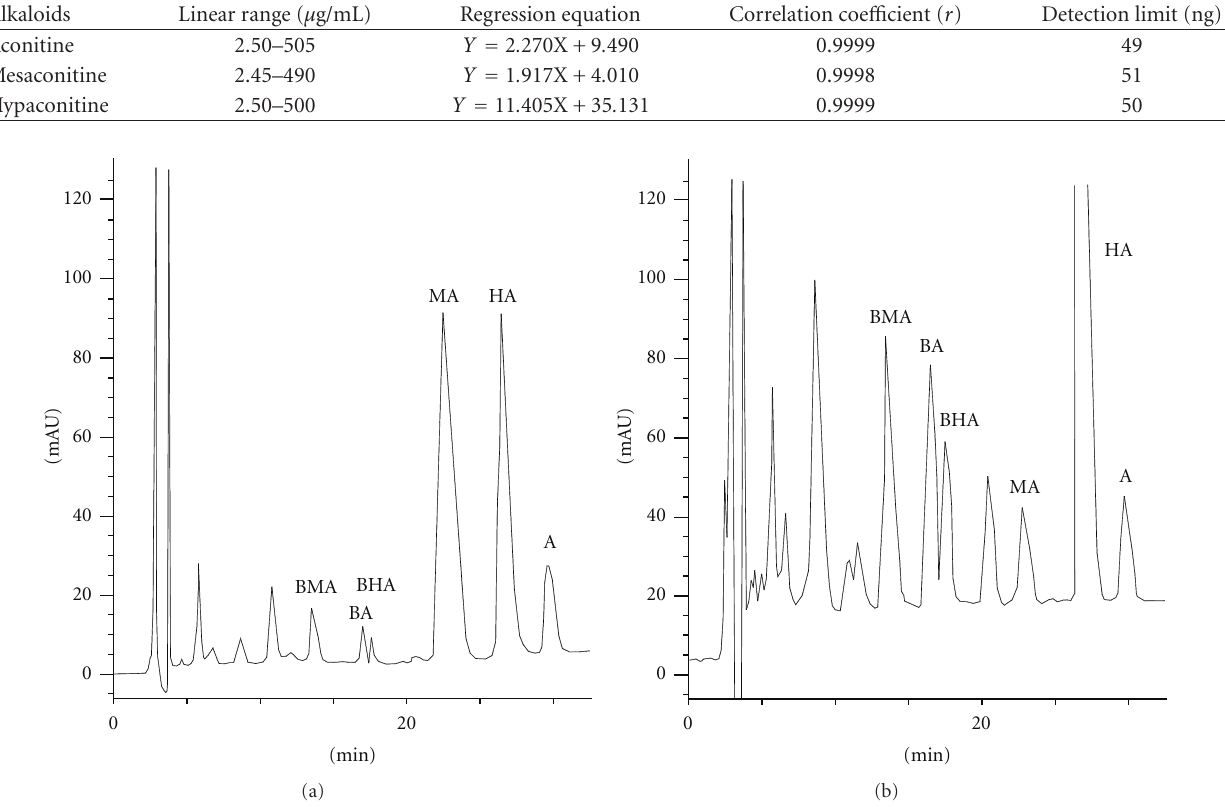
Figure 2: HPLC chromatograms of raw Chuanwu (a) and processed Chuanwu (b).